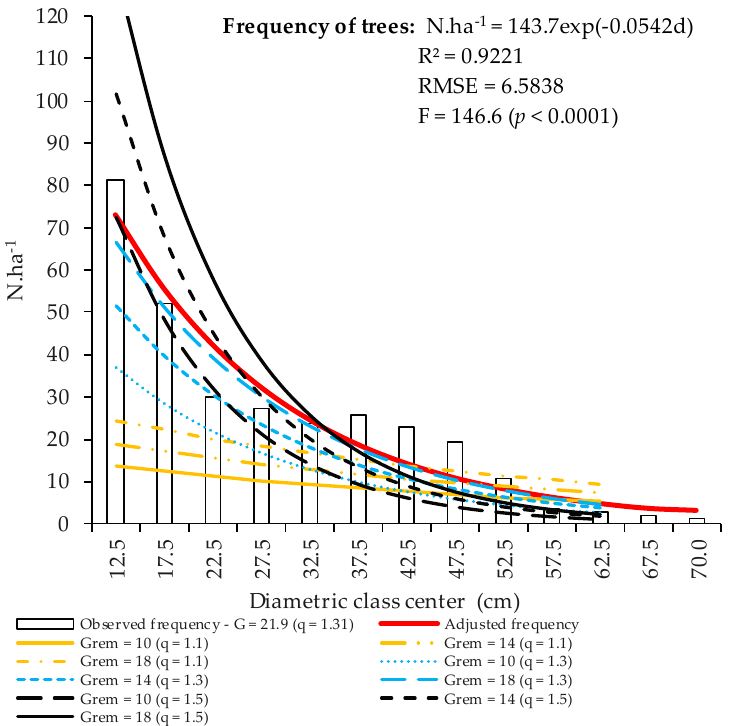
Figure 1. Distribution of observed and adjusted frequencies for A. angustifolia (Bertol.) Kuntze, aiming at the sustainability concept proposed by Liocourt’s law, in diametric classes, considering a remaining basal area of 10.0, 14.0, and 18.0 m 2 · ha − 1 ; and changing Liocourt’s quotient to 1.1, 1.3,